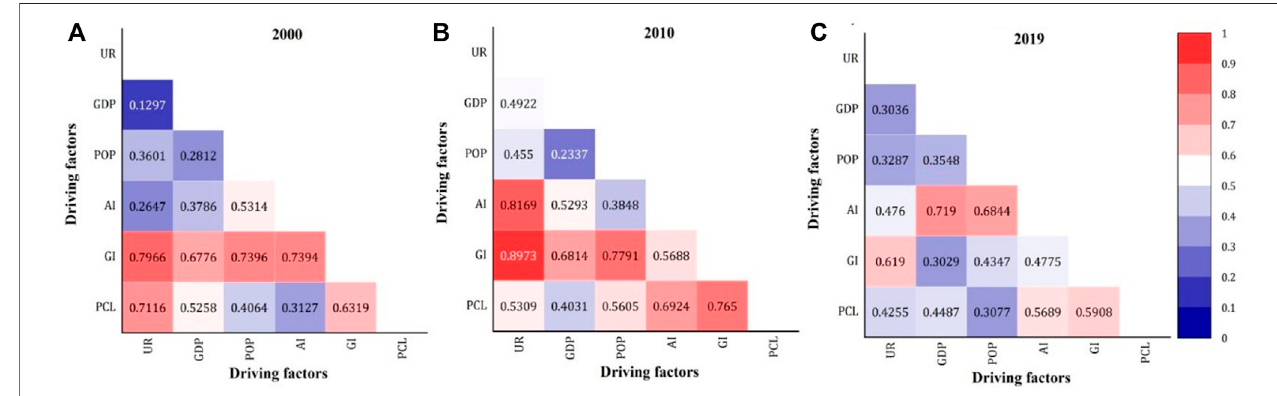
FIGURE9| Percentageofexplanation(qvalue)ininteractionin2000 (A) ,2010 (B) ,2019 (C) (UR:urbanizationrate,GDP:grossdomesticproductpercapita,POP: population density, AI: agricultural input, GI: grazing intensity, PCL: proportion of construction land).